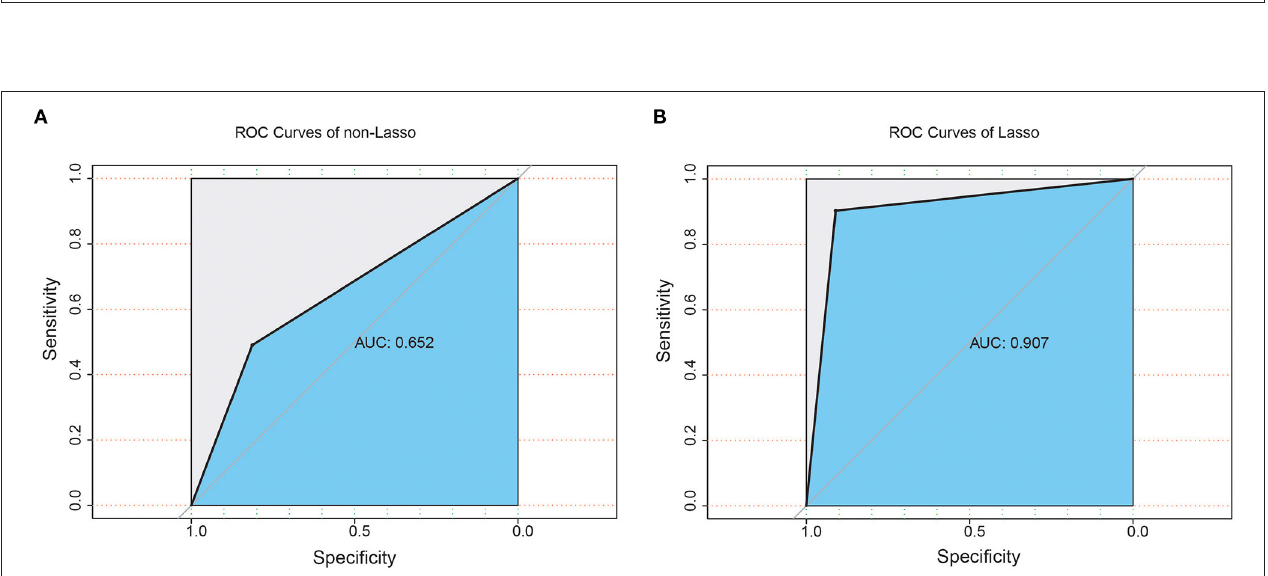
FIGURE 2 | Receiver operating characteristic (ROC) curve with area under the curve values for (A) non-Lasso regression and (B) Lasso regression.